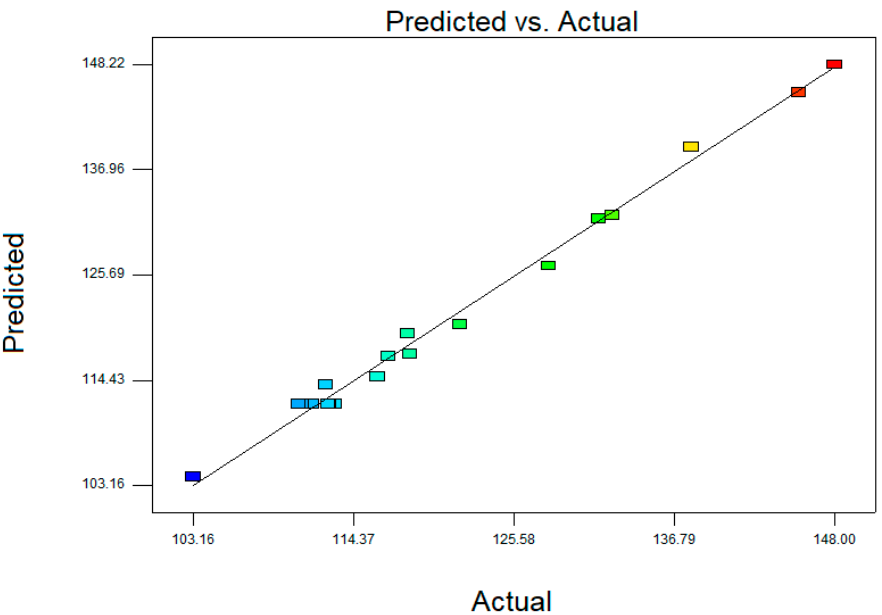
Figure 1. Scatter plot of predicted droplet size values versus actual droplet size values from three-factor central composite design (CCD).